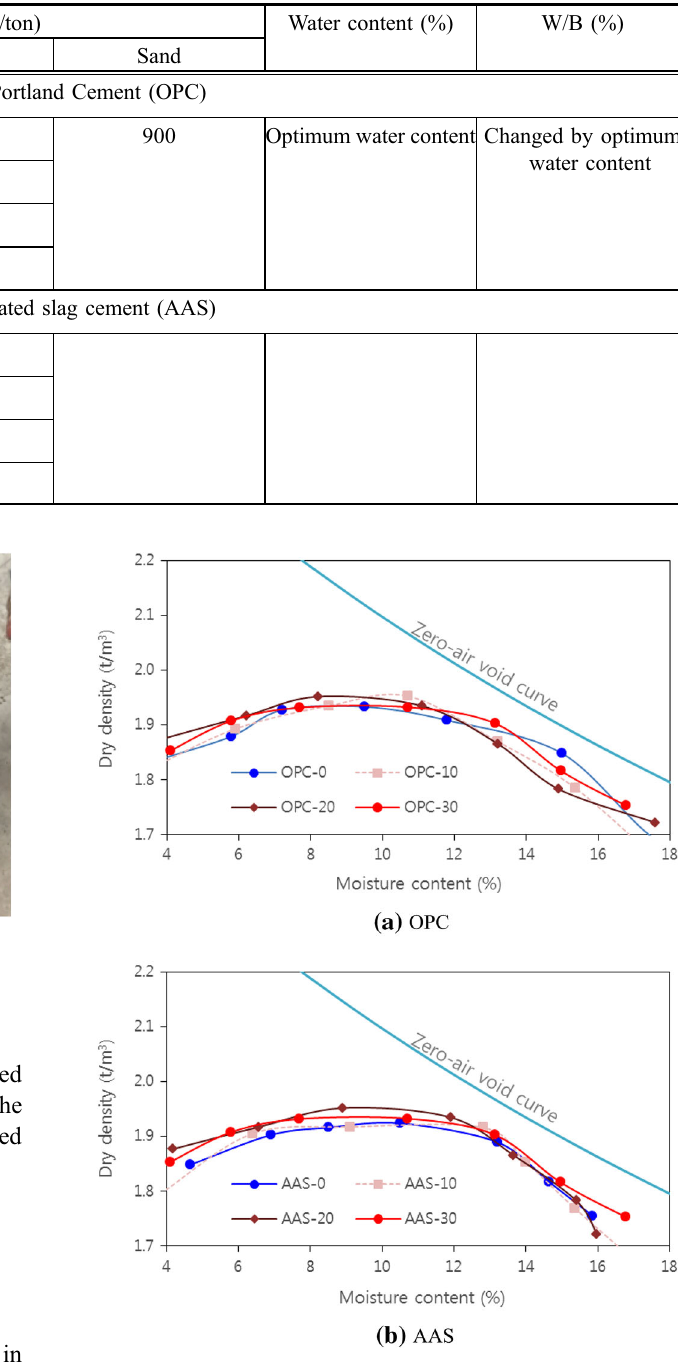
Fig. 5 Compaction characteristics with red mud replacement